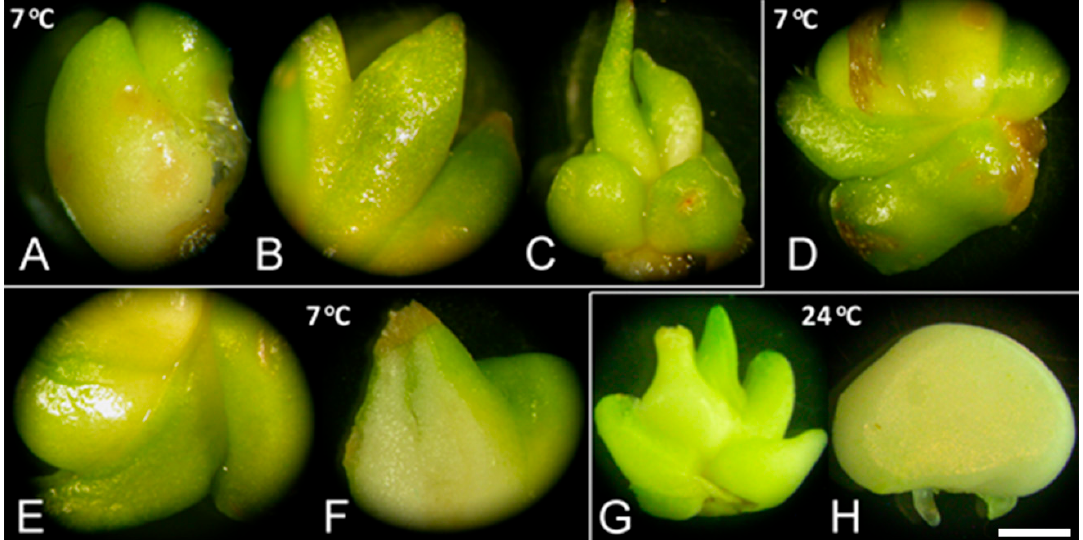
Figure 2. Sprouting of F. meleagris bulbs cultured at 7 and 24 °C. ( A – C ) Sprouted bulbs grown at 7 °C on culture medium without PGRs after one ( A ), three ( B ) and five weeks ( C ). ( D – F ) Sprouted bulbs grown at 7 °C on medium supplemented with 10 μ M GA 3 after one ( D ), two ( E ) and five weeks ( F ). ( G ) Bulbs grown for five weeks at 24 °C on culture medium without PGRs. ( H ) Bulbs grown for two weeks at 24 °C on culture medium supplemented with 10 μ M GA 3 . Scale bar = 3 mm.